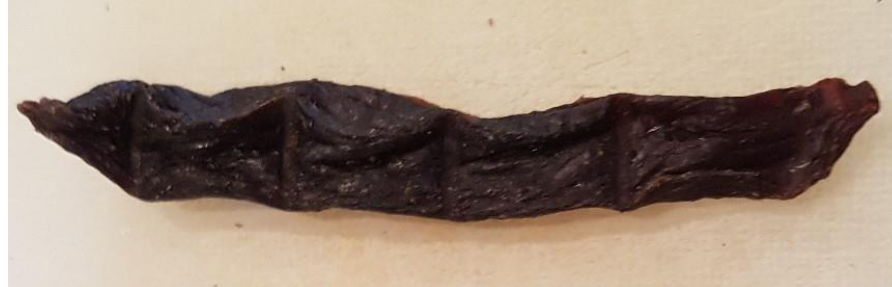
Figure 8. Diagram of the drying chamber with the sampling points marked. A—air inlet; B—air outlet. The arrows indicate the direction of the air flow. Sampling locations: UL—up left, UR—up right, ML—middle left, MR—middle right, DL—down left, DR—down right.